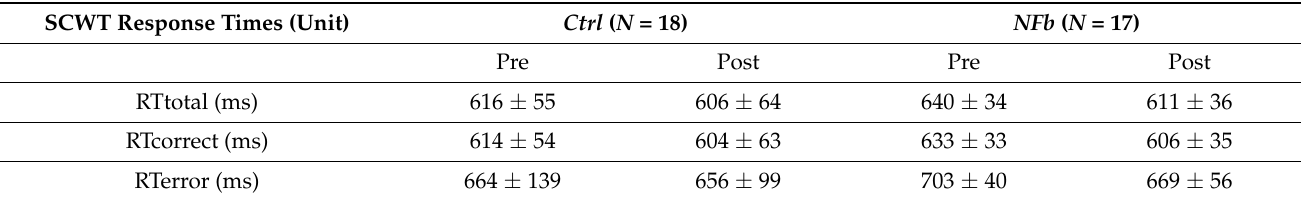
Table 1. Descriptive statistics (means ± standard deviations) of SCWT response